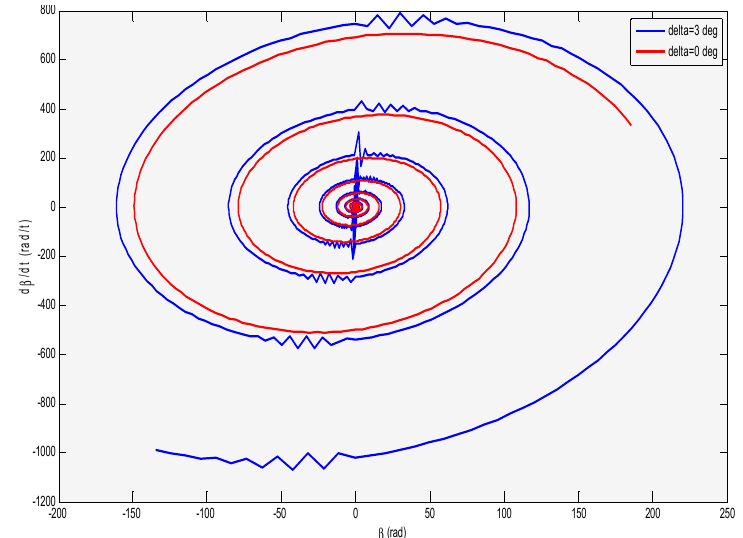
Figure 31. The state space response of beta without freeplay and with 2 ◦ freeplay. (In upper speed of flutter).